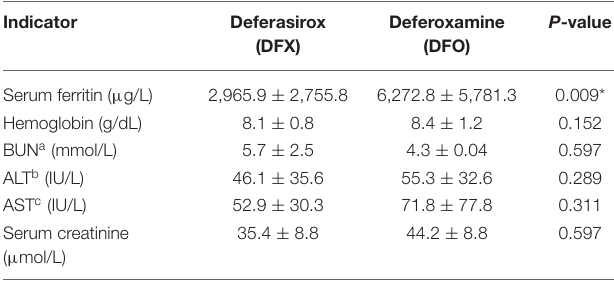
TABLE 4 | Means and SDs of all hematological and biochemical parameters for deferasirox receivers and deferoxamine receivers.